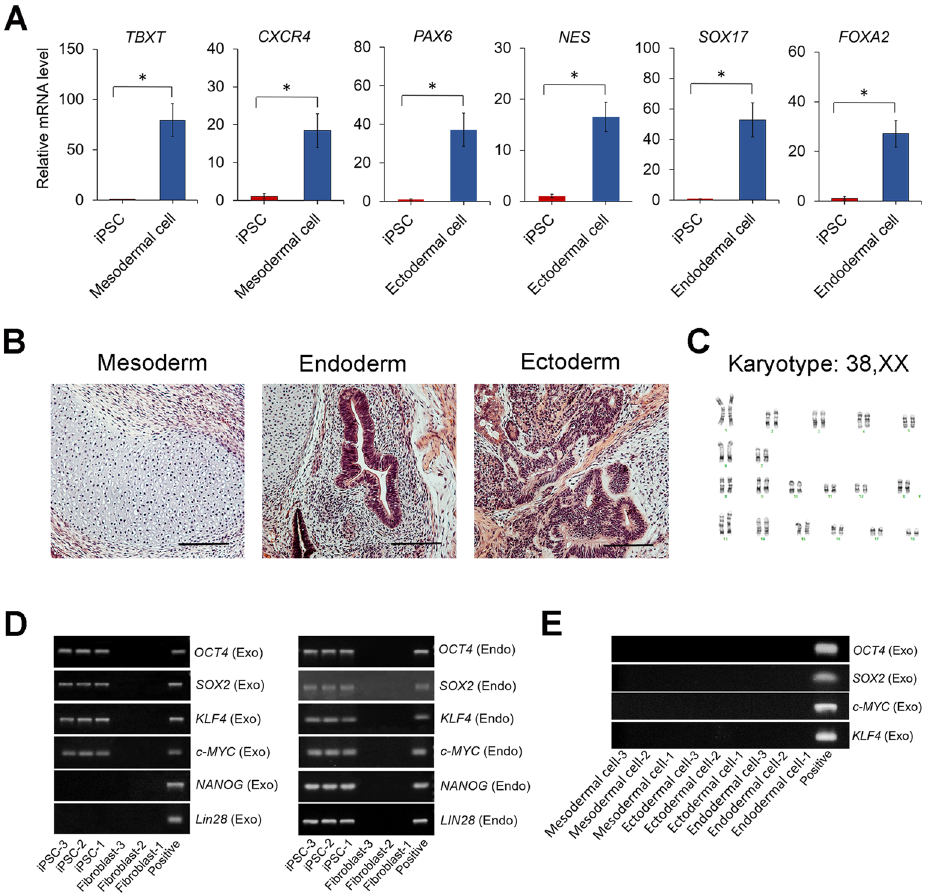
Figure 3. Derivation of 3 germ layer cells and karyotype of pig iPSCs. ( A ) Quantitative RT–PCR detecting relative mRNA levels of the germ layer-associated markers TBXT and CXCR4 (mesoderm), PAX6 and NES (ectoderm), and SOX17 and FOXA2 (endoderm) in cells derived from iPSCs after 7 days of germ layer- specific induction. ( B ) Hematoxylin and eosin (H&E) staining of teratomas derived from a representative pig iPSC line. Tissues of 3 germ layers, including cartilage (mesoderm), gut-like epithelium (endoderm), and neuronal rosette (ectoderm), were present in a teratoma. ( C ) Chromosome analysis of a representative iPSC line revealing a normal diploid pig cell with a 38, XX karyotype. ( D ) Expression of exogenous and endogenous pluripotency markers in 3 fibroblast lines (p5) and 3 iPSC lines (p15). ( E ) Expression of exogenous Yamanaka factors in mesodermal, ectodermal, and endodermal cells derived from iPSCs. Original gels are presented in Supplementary Fig. S4. Scale bar = 200 µm. * p < 0.05; n =